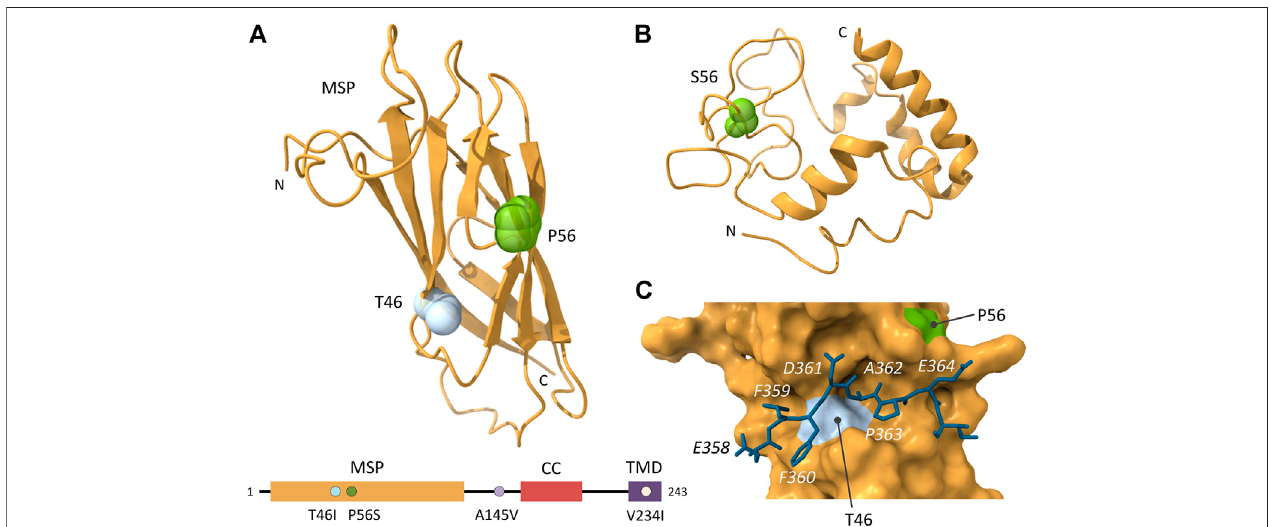
FIGURE3 | Structure ofthe VAP MSP domain. (A) Structure of the MSP domain of VAPB (PDB ID: 3IKK) and schematic representation ofthe domain architecture of VAPB,withthe ALS-relatedmutations indicated. The two ALS-related residues that are located in the MSPdomain (T46 and P56) are mapped onto the structure. (B) Structureofthe MSP domain ofVAPB P56S (PDB ID: 2MDK).TheALS-related mutation S56ismappedonto the structure. (C) Structure ofthe MSPdomain ofVAPA in